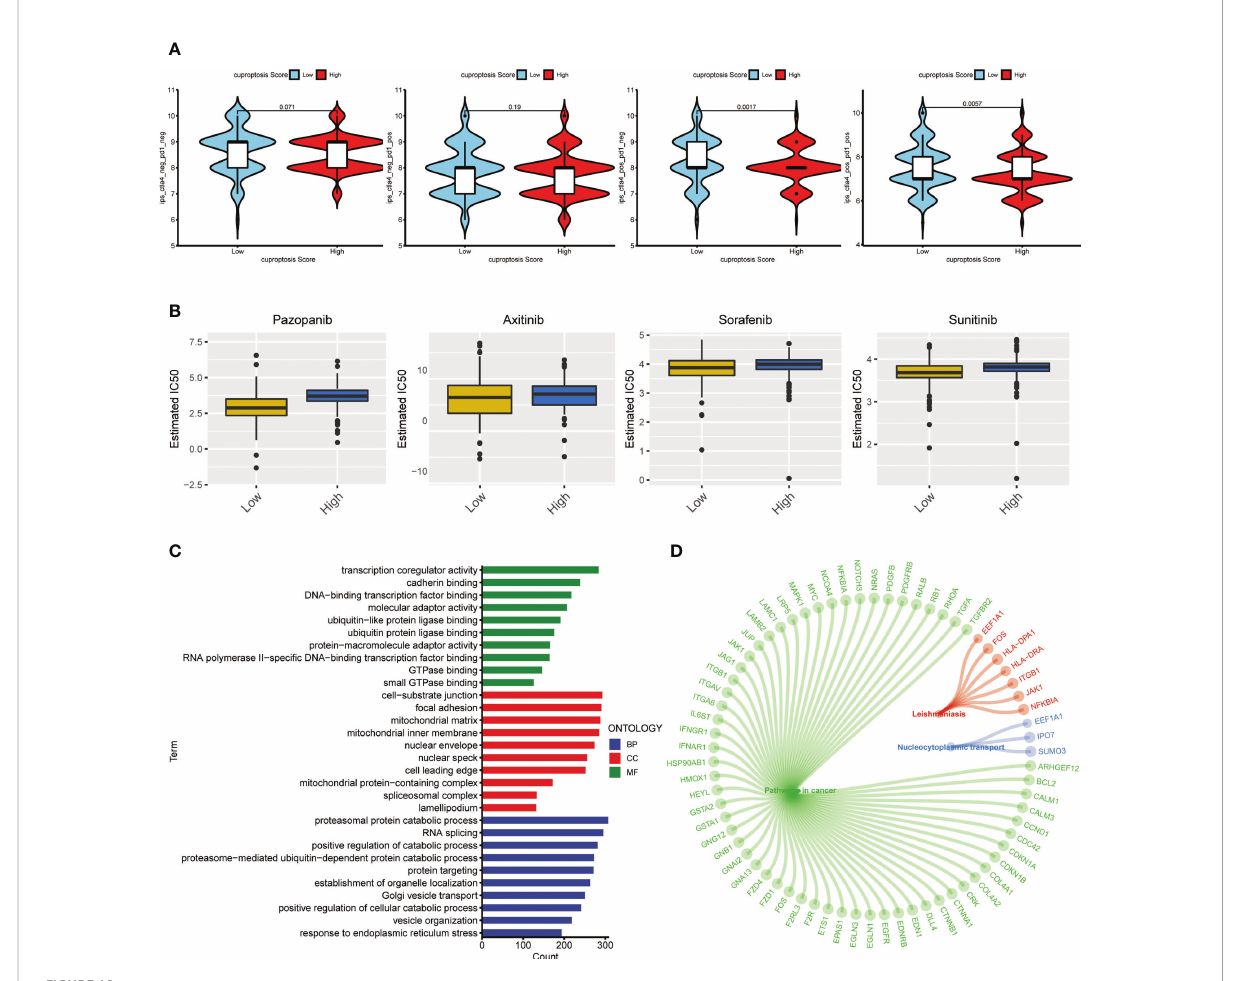
FIGURE 10 Therapeutic response correlation of the cuproptosis score in ccRCC. (A) IPS level in the high and low cuproptosis score groups. pos: positive; neg: negative. (B) Estimated treating response of agents in patients with high and low cuproptosis scores. (C) GO analysis on DEGs from patients with high and low cuproptosis scores. (D) Circle plot of representative pathways and hub genes. IPS: immunophenotype score. GO: gene ontology. DEGs, differentially expressed